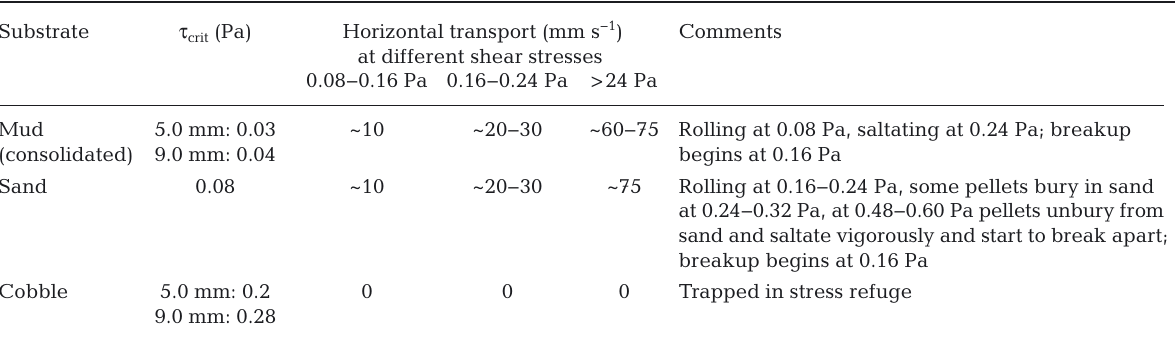
Table 2. Transport paramenters of salmon feed pellets (5.0 and 9.0 mm diameter) on each substrate type used in the erodibility study. τ crit is the shear stress required for incipient motion of feed